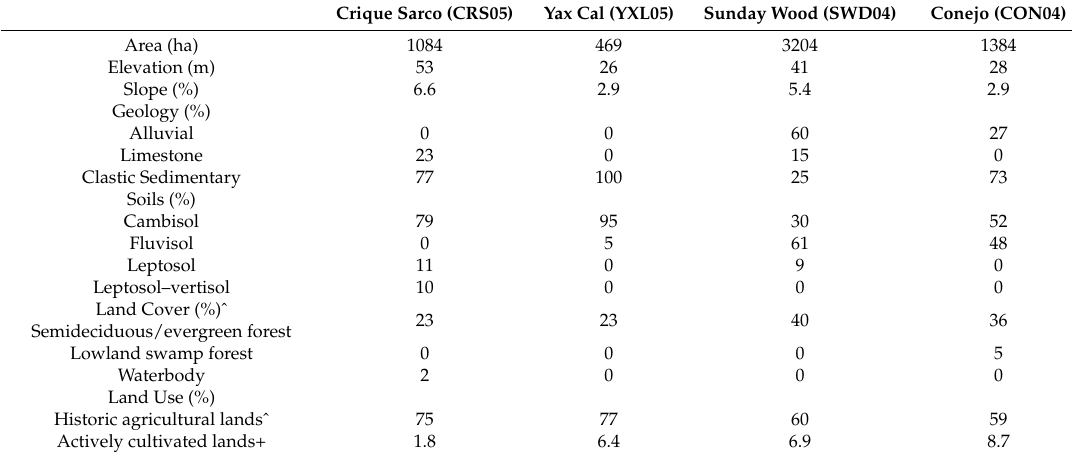
Table 1. Catchment characteristics of the four study catchments in the Temash River watershed (all data are for the catchment area of the farthest downstream sampling